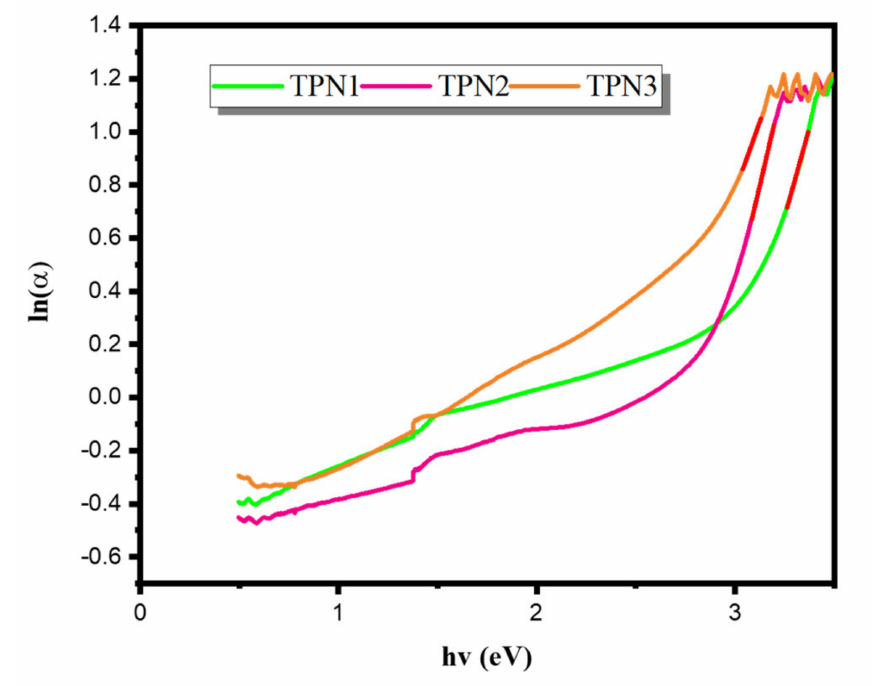
Figure 3. Plot of ln( α ) as a function of the photon energy (h v ) of prepared